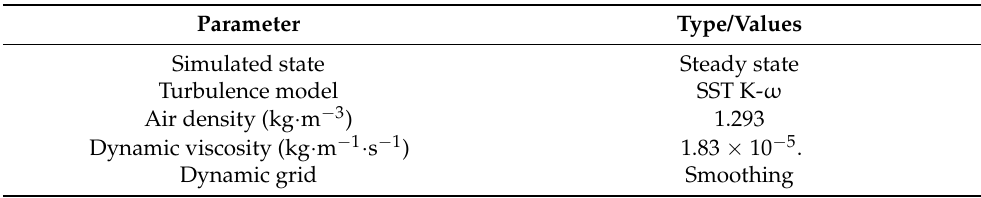
Table 5. Settings of solution mode of